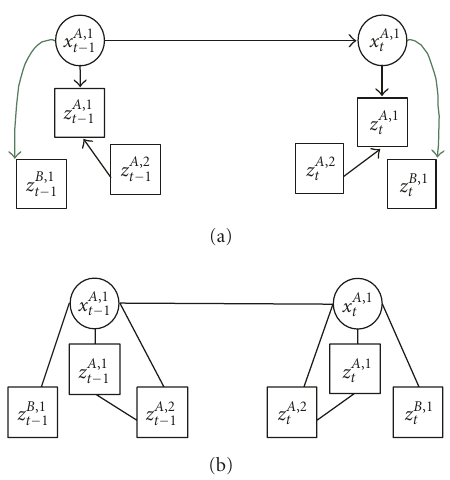
Figure 3: (a) Decomposition result for the target 1 in view A from Figure 1; (b) the moral graph of the graphical model in (a) for Markov property